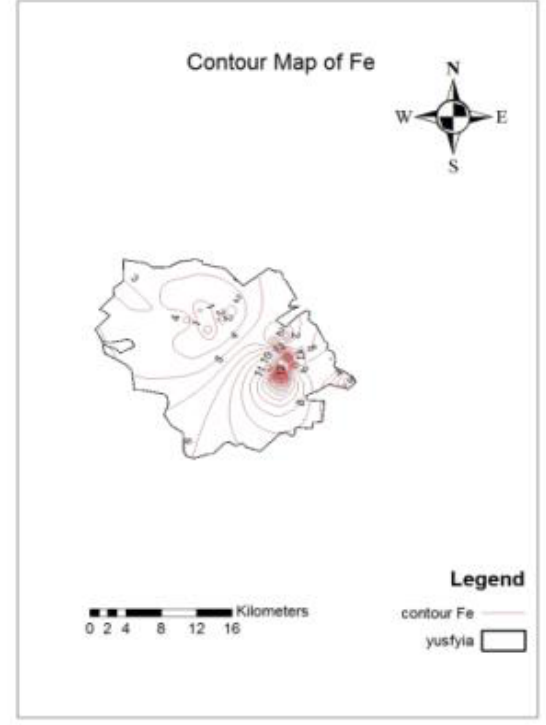
Fig.13: The interpolation and contour line of Fe map in